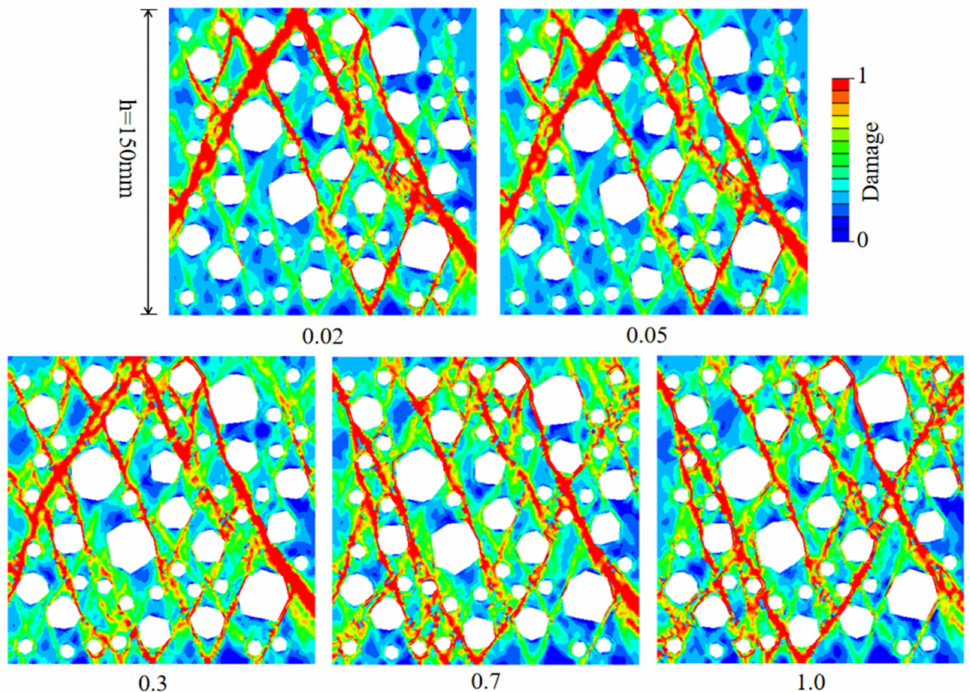
Figure 17. The effect of ITZ thickness on the failure mode of RAC under uniaxial